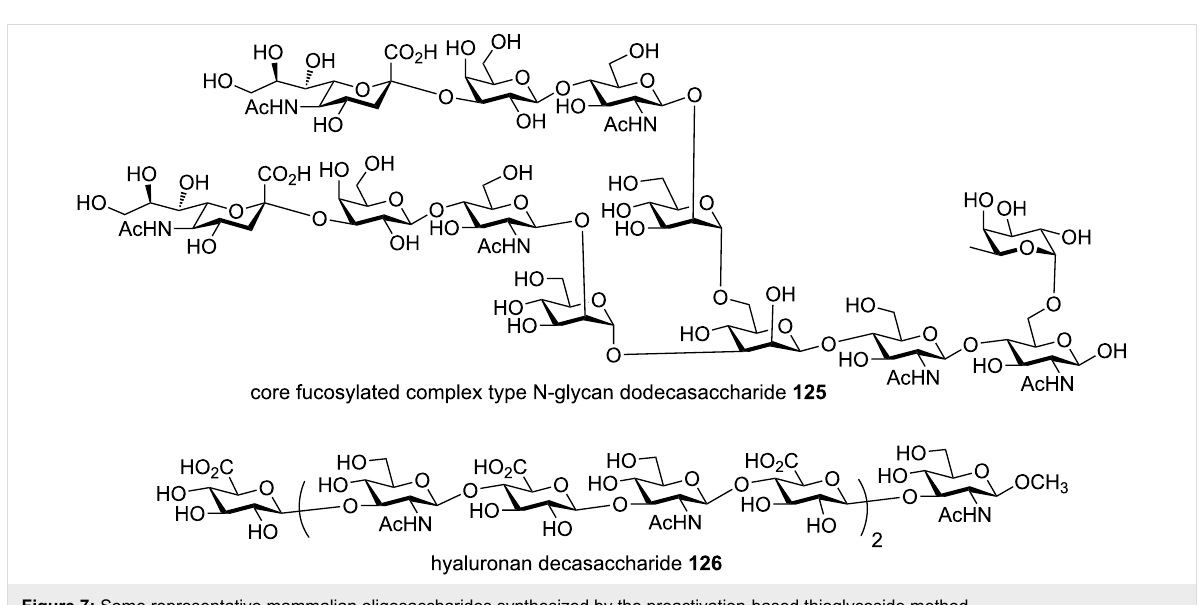
ported a fluorine-assisted one-pot method, where no silica gel column chromatography was required [80]. To demonstrate the applicability of this method, a linear tetrasaccharide was synthe-